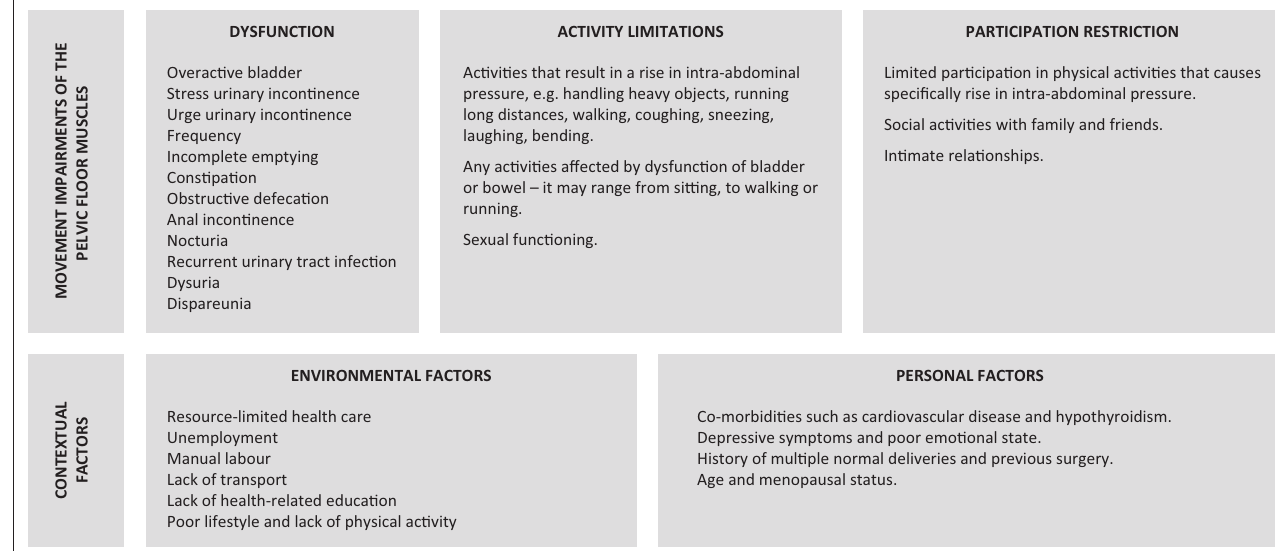
FIGURE 2: Discussion of findings using an International Classification of Function, and Disability and Health framework for patients with pelvic organ prolapse in a South African